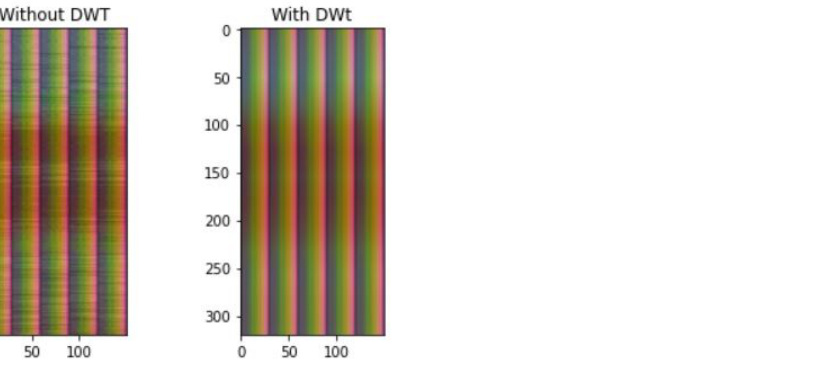
Figure 12. Amplitude sample visualized with and without DWT (wavelet: “sym3”, decomposition threshold